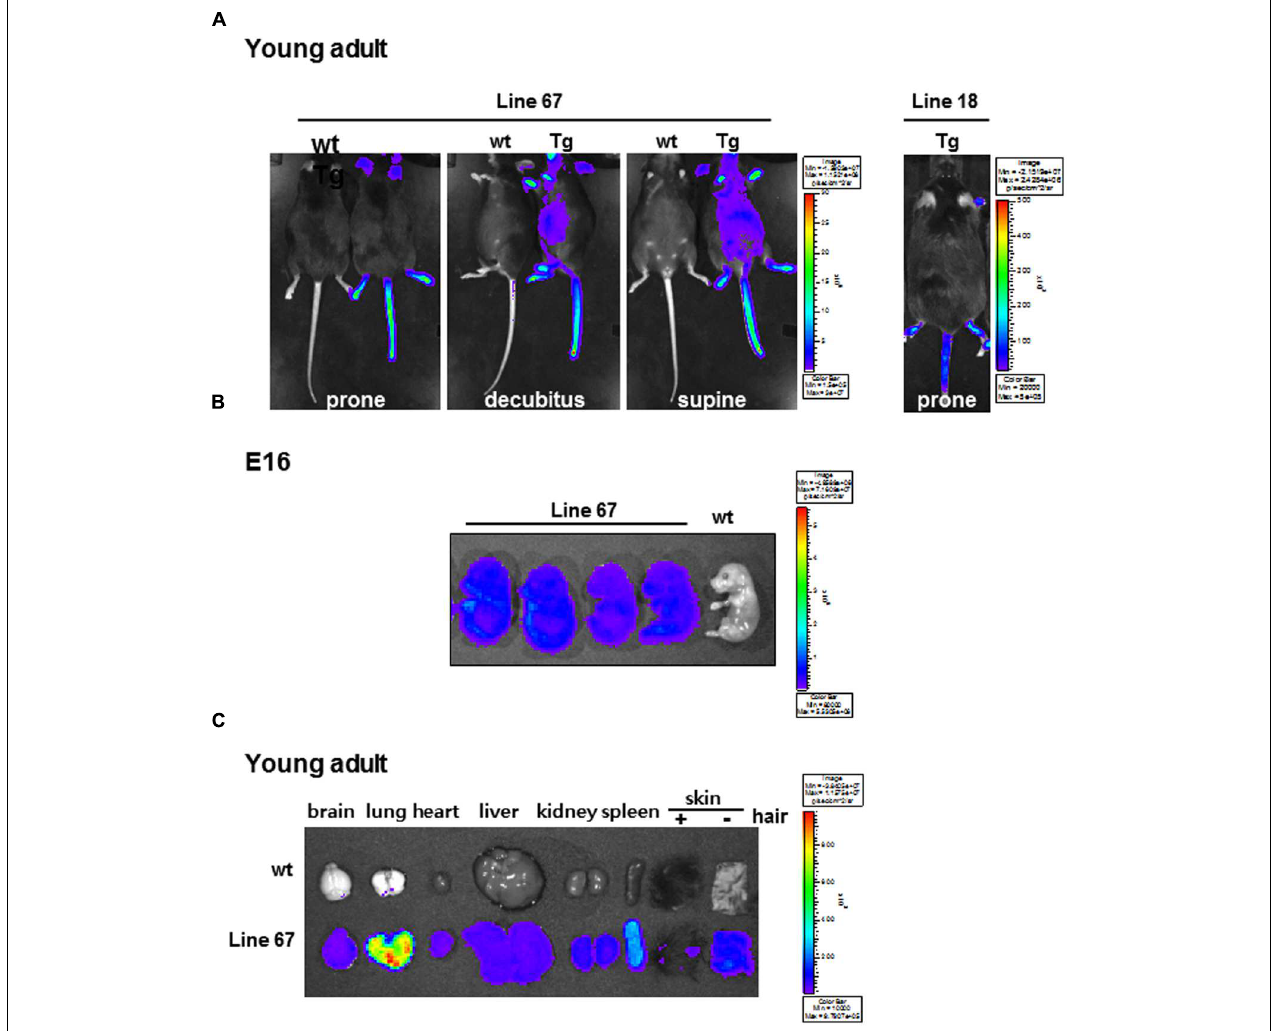
FIGURE 2 | Bioluminescence images of candidate miR-124 reporter-expressing transgenic mice. (A) Whole body bioluminescence images of wt and transgenic mice harboring effluc-eGFP-miR-124_3 × PT acquired with D -luciferin injection. The acquisition time of line 67 (left) and line 18 (right) was 10 s and 600 s, respectively. (B) Ex vivo images of effluc reporter activity of fetuses of wt mouse and transgenic mice (line 67) at E16 period. (C) Ex vivo images of major organs excised from a wt and a transgenic mouse (line